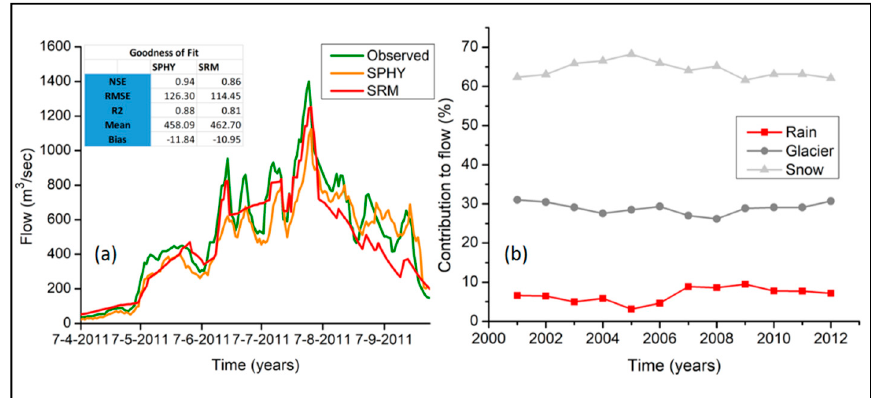
Figure 10. ( a ) Hydrographs showing observed (gauged) and measured (simulated) discharge during the months of April to September of 2011 at Gilgit River at Gilgit used for calibration of Snowmelt runoff Model (SRM) and Spatial Processes in Hydrology (SPHY); ( b ) Rain, glacier, and snow melt contribution to flow at Gilgit River at Gilgit using SPHY for validation.